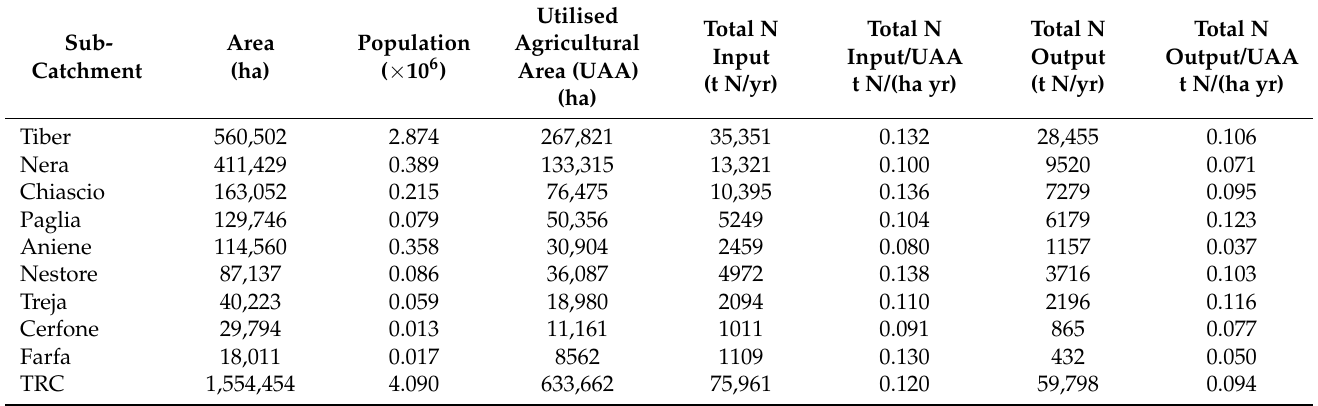
Table 1. Data regarding the Tiber River catchment (TRC) and its sub-catchments. All of the data come from the database of the Italian National Institute of Statistics (ISTAT), which was produced as part of the sixth agricultural census in 2010.